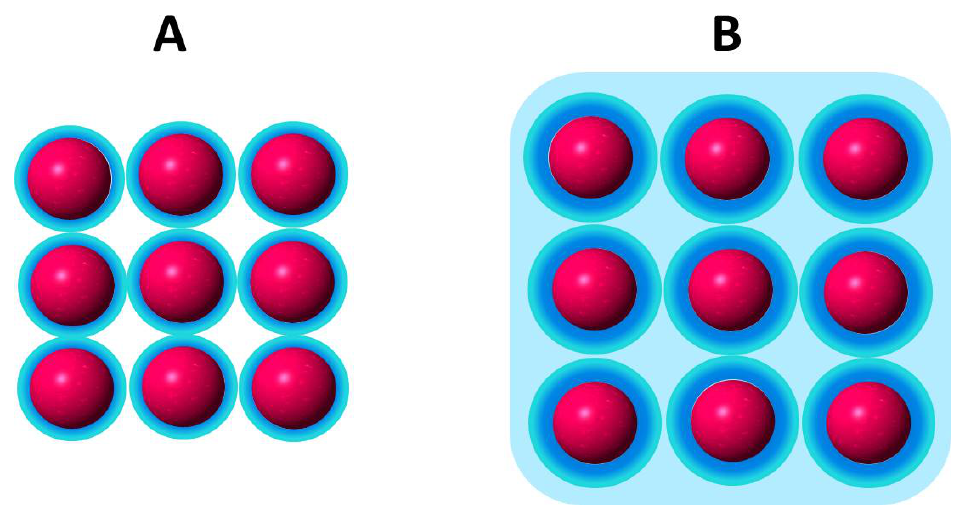
Figure 2. Schematic representation of the excluded volume in the head group region (red spheres) of a lipid membrane. ( A ). Blue region: hardcore first hydration shell. ( B ). Light blue region: water available as solvent (confined water) although of different properties than bulk water.